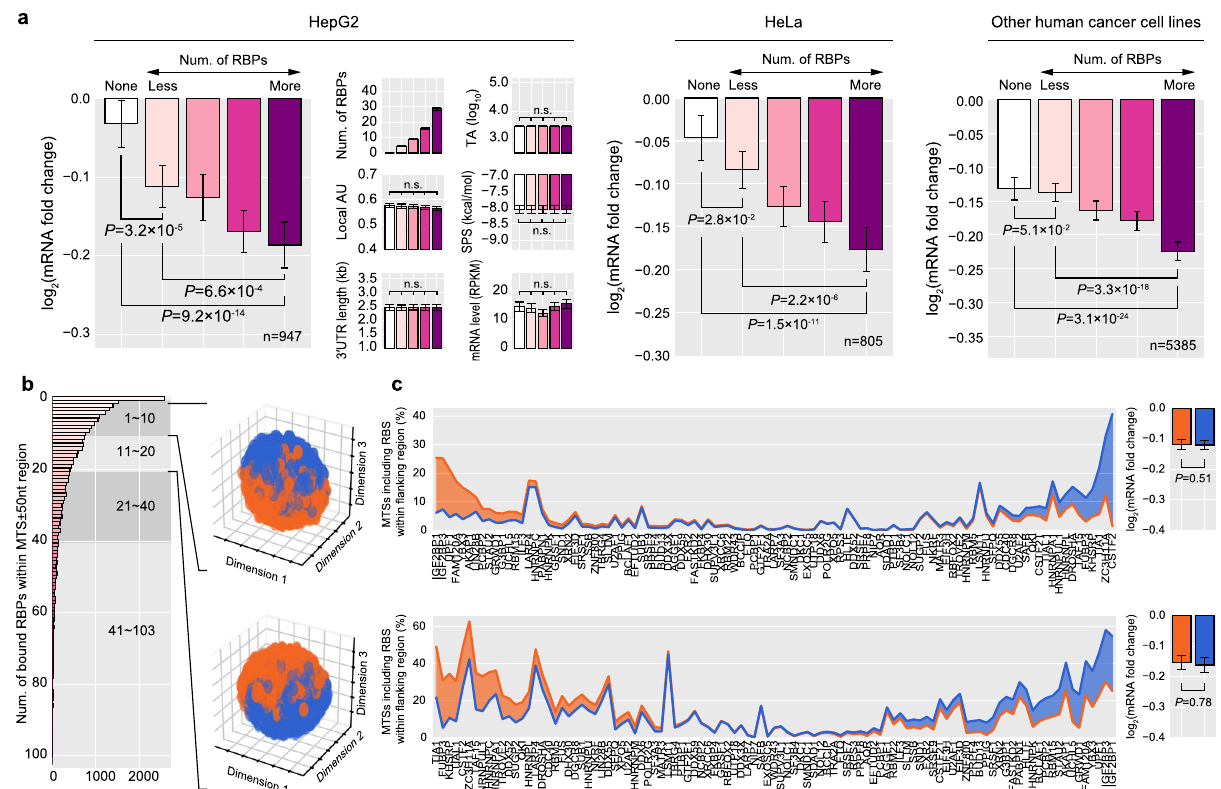
Fig. 3 Combined effect of RBPs on miRNA targeting (MT). a Association analysis between the number of RBPs bound close to the miRNA target site (MTS) and MT ef fi cacy. 3 ′ UTRs were separated into fi ve subgroups with respect to the number of RBPs bound within 50 nts from the MTS. Each subgroup was carefully selected to have statistically indistinguishable confounding features among subgroups (see Methods). mRNA fold changes and values of confounding features were compared among these subgroups (two-sided Wilcoxon ’ s rank-sum test) with the mean values of confounding features and log 2 (mRNA fold change) displayed. The error bars represent 95% con fi dence intervals of the values. For full versions for HeLa and other human cancer cell lines, see Supplementary Fig. 2a, b. b Distribution of MTSs with respect to the number of RBPs bound within 50 nt fl anking regions in HepG2 data (left) and the separation of MTSs by the composition of bound RBPs (right). MTSs with the number of bound RBPs between 1 and 10 were collected and separated into two subgroups with similar number of bound RBPs but different RBP compositions (top right, see Methods). Similarly, those MTSs with the number of RBPs between 11 and 20 were collected and analyzed (bottom right). For full versions that also include the MTSs with the number of RBPs greater than 20, see Supplementary Fig. 3a. c For the two subgroups separated from the MTSs with the number of bound RBPs between 1 and 10, the RBP compositions (top left) and the mean MT ef fi cacies (top right) are depicted and compared. For each RBP shown on the x -axis, the fraction of MTSs including an RBS within 50 nt fl anking regions is displayed on the y -axis (top left). mRNA fold changes were compared between the two subgroups (top right, two-sided Wilcoxon ’ s rank-sum test). Similarly, for the two subgroups separated from the MTSs with the number of bound RBPs between 11 and 20, the RBP compositions (bottom left) and the mean MT ef fi cacies (bottom right) are depicted and compared. Otherwise as in ( b ). For full versions that also include the MTSs with the number of RBPs greater than 20, see Supplementary